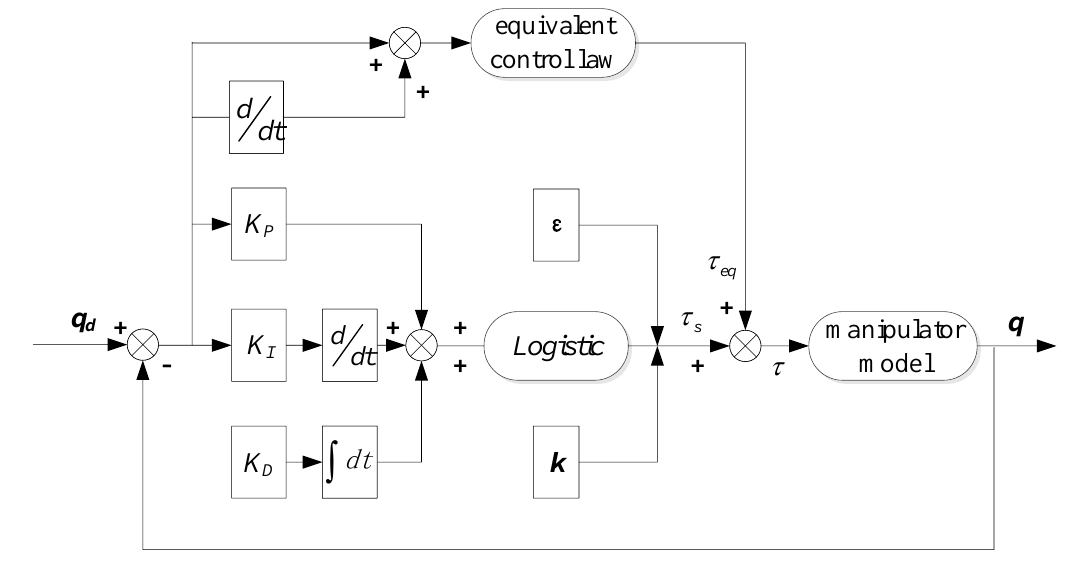
Figure 2. Block diagram of the adaptive gravity compensation architecture of a space robotic